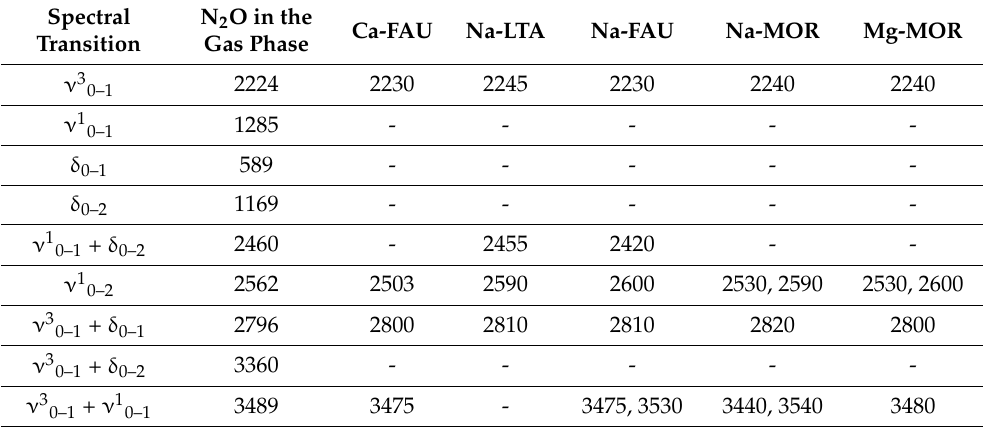
Figure 1. IR spectra of N 2 O adsorbed at 20 ◦ C and 10 Torr on Na-MOR (1), Na-LTA (2), Na-FAU (Y) (3), Ca-FAU (Y) (4), and Mg-MOR (5). Table 1. Frequencies (cm − 1 ) of IR bands of N 2 O adsorbed on cationic forms of the zeolites under